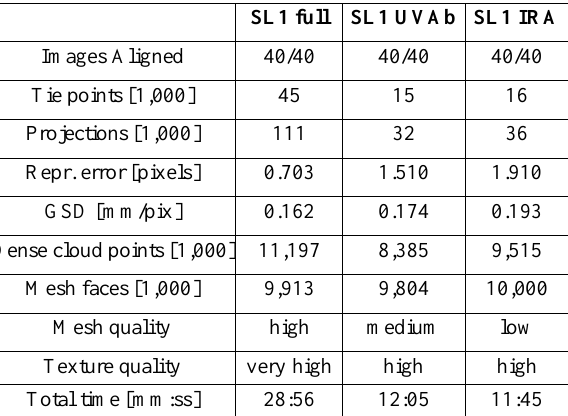
Table 8: Agisoft Metashape results OBJ2